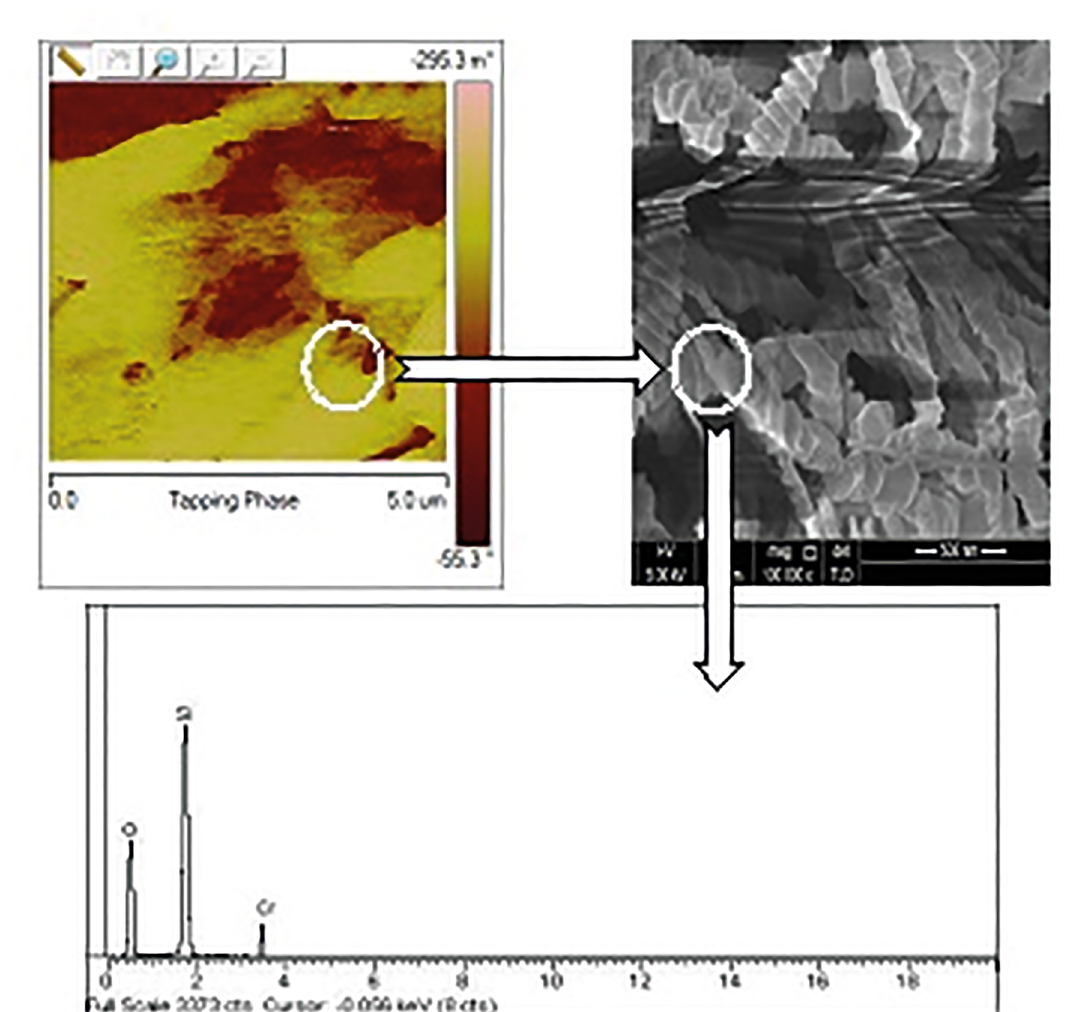
Figure 7. SEM of debris corresponding to the EDS and AFM.analysis of the wear particle at 15 N.